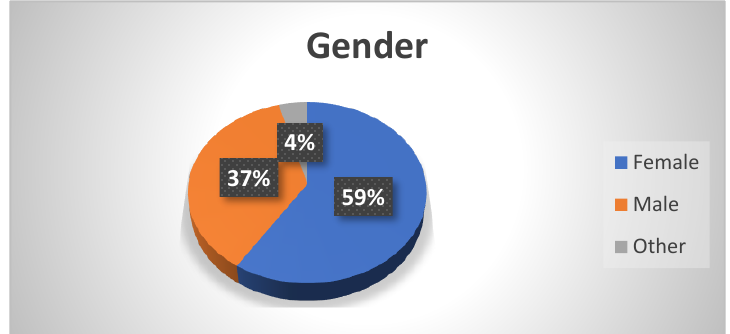
Figure 17. Gender percentages of the 71 university students.